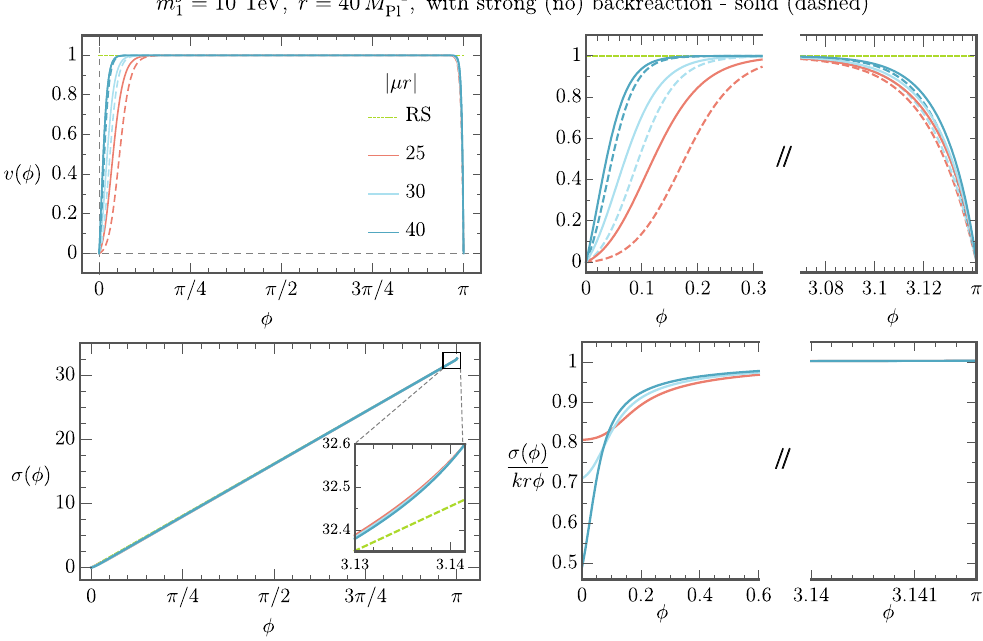
Figure 6 . Background solutions for (cid:13) = 0 (no backreaction limit) and (cid:13) = 0 : 5 (strong backreaction) and di(cid:11)erent values of (cid:22)r . Upper panels show the scalar VEV solutions for RS (with sgn( (cid:30) ) j j function) and (cid:22)r = 25 ; 30 and 40, with the upper right (cid:12)gure emphasizing the behavior of the j j VEV near the branes. Analogous plots are shown for the warp function (cid:27) ( (cid:30) ) in the lower panels. \zoomed" region near the branes (right). The lower panels show the warp function, (cid:27) ( (cid:30) ) (left), and the ratio of the warp function with respect to the RS solution, (cid:27) ( (cid:30) ) =kr(cid:30) (right), again the latter only showing values of (cid:30) close to the branes. Note that again for (cid:22) (corresponding to b if no tuning is assumed) we reach the decoupling limit where ! 1 v ( (cid:30) ) sgn( (cid:30) ), i.e. the dynamics of the bulk scalar freezes. Therefore, for a generic !